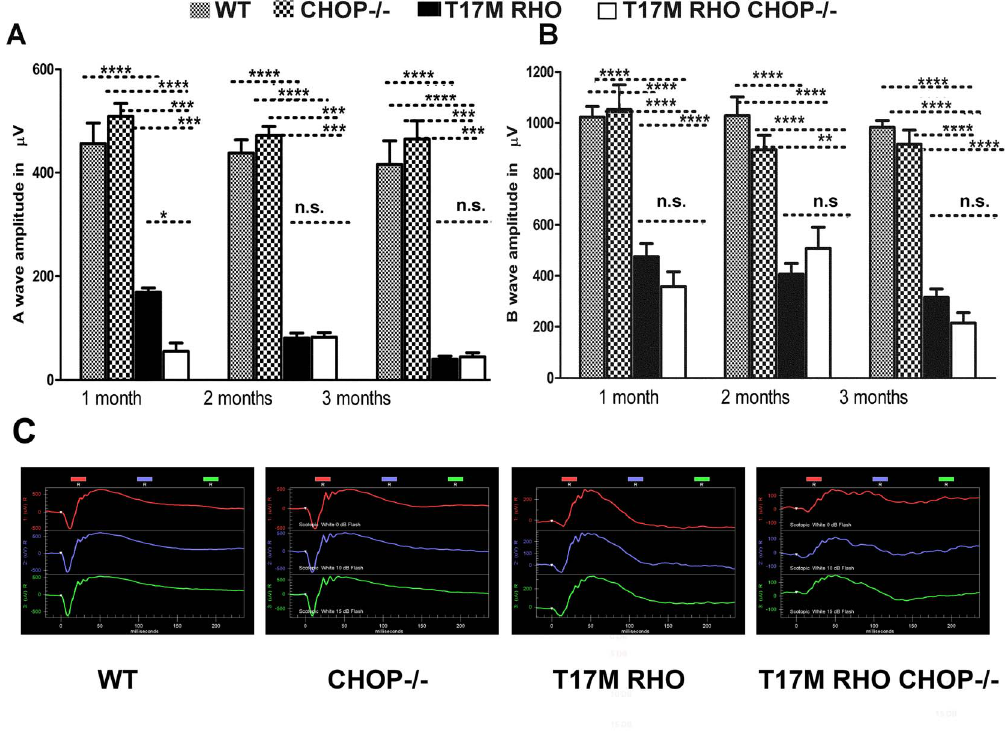
Figure 1. Lack of CHOP protein does not protect T17M RHO retinas from degeneration, as measured by scotopic ERG responses at 10DB. We analyzed 4 groups of animals (N=6). A: The a-wave of the scotopic ERG amplitude was diminished in T17M RHO CHOP 2 / 2 mice at 1 month of age and the values of a-wave amplitudes were 456.3 m v 6 39.7 in wild-type; 509.1 m v 6 24.9 in CHOP 2 / 2 ; 169.0 m v 6 7.9 in T17M RHO ; and 54.4 m v 6 16.4 in T17M RHO CHOP 2 / 2 . This data reflected a 70% difference in the a-wave amplitudes between T17M RHO and T17M RHO CHOP 2 / 2 mice. The differences between all groups were statistically significant ( P , 0.0001). The difference between wild-type and CHOP 2 / 2 mice was not significant (n.s.). In the 2 nd and the 3 rd months, the a-wave amplitudes declined in T17M RHO mice but did not decline any further in T17M RHO CHOP 2 / 2 mice (90.7 m v 6 13.5 in T17M RHO vs. 82.05 m v 6 8.7 in T17M RHO CHOP 2 / 2 at 2 months and 39.7 m v 6 5.7 in T17M RHO vs. 44.0 m v 6 8.20 in T17M RHO CHOP 2 / 2 at 3 months). In wild-type mice, the a-wave amplitude was 438.2 6 25.4, vs. 472 m v 6 17.3 in CHOP 2 / 2 mice at 2 months, while it was 416.2 m v 6 45.5 in wild-type vs. 464.9 m v 6 35.2 in CHOP 2 / 2 mice at 3 months. At 2 and 3 months, the differences between wild-type or CHOP 2 / 2 and T17M RHO or T17M RHO CHOP 2 / 2 groups were significant ( P , 0.001), but we did not register any differences between wild-type and CHOP 2 / 2 mice at 1, 2, or 3 months of age and difference between T17M RHO and T17M RHO CHOP 2 / 2 mice at 2 and 3 months of age. B: The b- wave of the scotopic ERG amplitude was decreased in T17M RHO CHOP 2 / 2 mice over the 3 examined months when compared to T17M RHO retinas. In 1-month-old animals, the b-wave amplitudes were 1023.0 m v 6 41.6 in wild-type; 1052.0 m v 6 96.5 in CHOP 2 / 2 ; 475.6 m v 6 50.7 in T17M RHO ; and 358.2 m v 6 58.2 in T17M RHO CHOP 2 / 2 . The differences between all groups were statistically significant ( P , 0.0001), except between T17M RHO and T17M RHO CHOP 2 / 2 , which was not significant. In the 2 nd and 3 rd months, the b-wave amplitudes in the T17M RHO mice declined. However, in the T17M RHO CHOP 2 / 2 mice, they were consistently low during the next 2 months. The b-wave amplitudes were 407.1 m v 6 41.7 in T17M RHO vs. 428.7.5 m v 6 67.0 in T17M RHO CHOP 2 / 2 at 2 months and 315.3 m v 6 32.7 in T17M RHO vs. 214.9 m v 6 40.0 in T17M RHO CHOP 2 / 2 at 3 months and were not significantly different. No difference was detected between the wild-type and CHOP 2 / 2 mice (1028.0 m v 6 73.4 in wild-type vs. 894.7 m v 6 56.9 in CHOP 2 / 2 at 2 months and 982.4 m v 6 26.4 in wild-type vs. 916.2 m v 6 55.5 in CHOP 2 / 2 at 3 months). However, at 2 months, the differences between the wild-type and T17M RHO or T17M RHO CHOP 2 / 2 mice were significant at the P , 0.0001 level as were those between